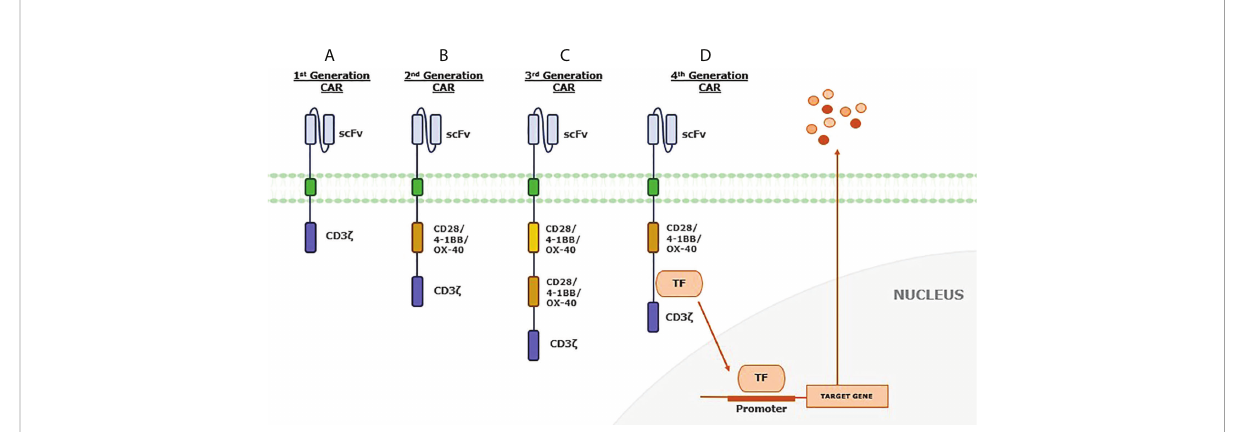
FIGURE 1 Chimeric antigen receptor (CAR) generations. (A) First-generation CAR includes a single-chain variable fragment (scFv) extracellular region and a T-cell activation domain. This minimal structure can recognize the antigen in an HLA-independent manner. By adding a costimulatory domain, (B) second-generation CAR is more able to expand and persist due to this second signal. (C) The third-generation CAR has an additional costimulatory signaling domain to increase proliferation, survival, and activity of engrafted T cells. Recently, (D) the fourth-generation CAR has been developed to include extra genes, such as recognition domains for transcription factors involved in mediating signal transduction. The idea is to modulate the effect of the CAR, facing an immunosuppressive tumor microenvironment by cytokine production or other additional